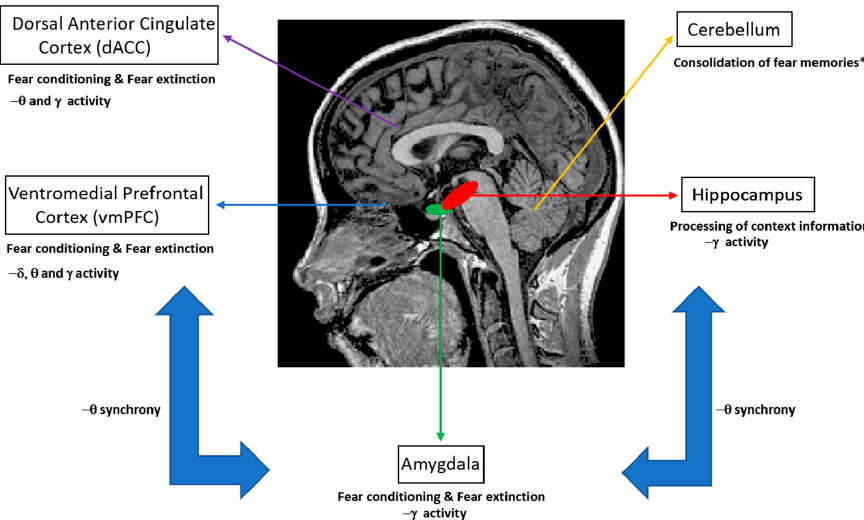
Figure 1. Human brain regions that have been investigated in studies of fear conditioning and fear extinction. Here, we emphasize the relevant neural oscillatory correlates ( δ : delta oscillations; θ : theta oscillations; γ : gamma oscillations) of such mechanisms, as suggested by animal and human studies. * Note that the role of the cerebellum in conditioning and extinction of fear is a matter of current research. Nevertheless, functional aspects such as the consolidation of fear memories have been suggested by previous studies